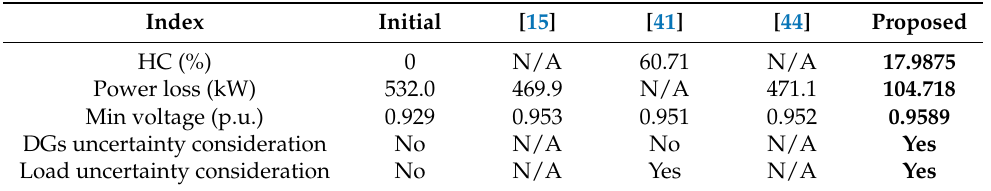
Table 15. A comparison with previous works based on system’s performance indices for the 83-node distribution network.